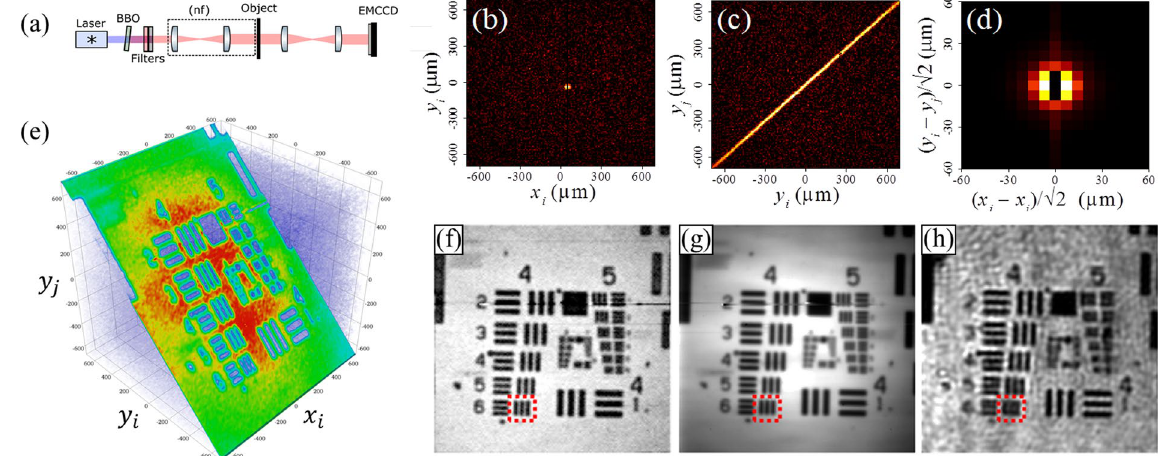
Figure 3. Biphoton imaging of a USAF resolution chart with an EMCCD camera (a) Experimental setup for (without the imaging with the near-field of the biphoton distribution. ( b – d ) Measurements of incident Γ ij Γ for fixed x x [ , ] Γ for = = µ = − µ j x y [ 50 m, 40 m] , ( c ) 2D slice of , and ( d ) object), showing ( b ) i i ij i j i j projection onto the difference coordinates. Each shows a high degree of spatial correlation. Black region = x x j i in ( b , d ) results from zeroing to eliminate the artifact from charge transfer inefficiency (see Methods and Supplementary Information). ( e ) 3D projection of Γ onto x y y ( , , ) , shows both the image of the resolution ij i i j chart and spatial correlation of the entangled photons. ( f – h ) Comparison of imaging ( f ) Γ ij and ( g ) Γ i (via singles counts) of entangled photon pairs at 800 nm and ( h ) classical coherent light at 808 nm. Red boxed highlights enhanced in visibility of group 4, element